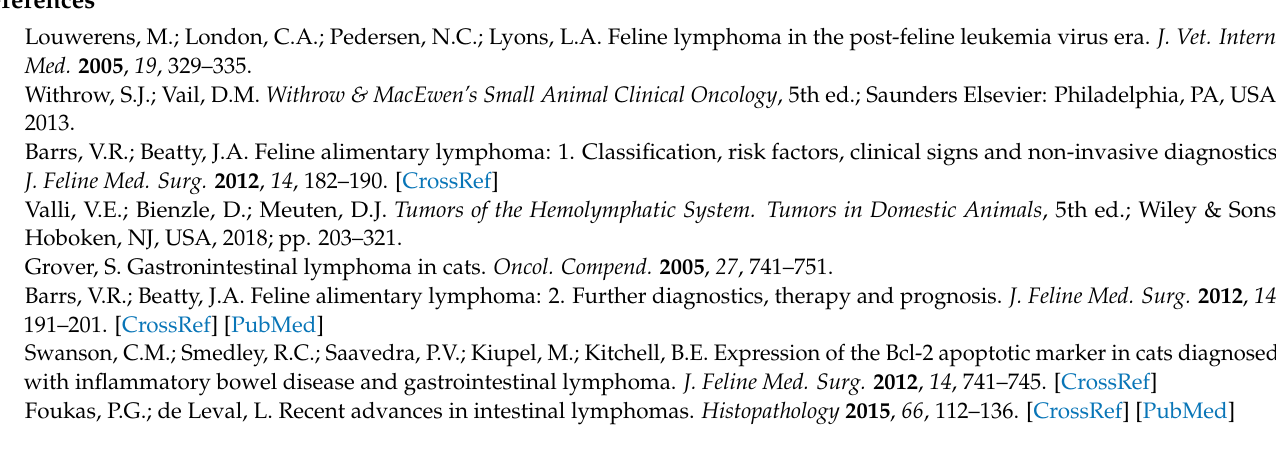
Agarose Gels. Table S1: Details of feline lymphoma sample cohort, Table S2: Oligonucleotides for PCR, qPCR and ARMS-qPCR assays, Supplementary Data: Template dsDNA fragments for ARMS